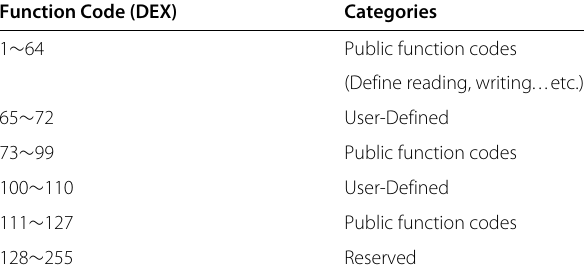
Table 1 Modbus function code